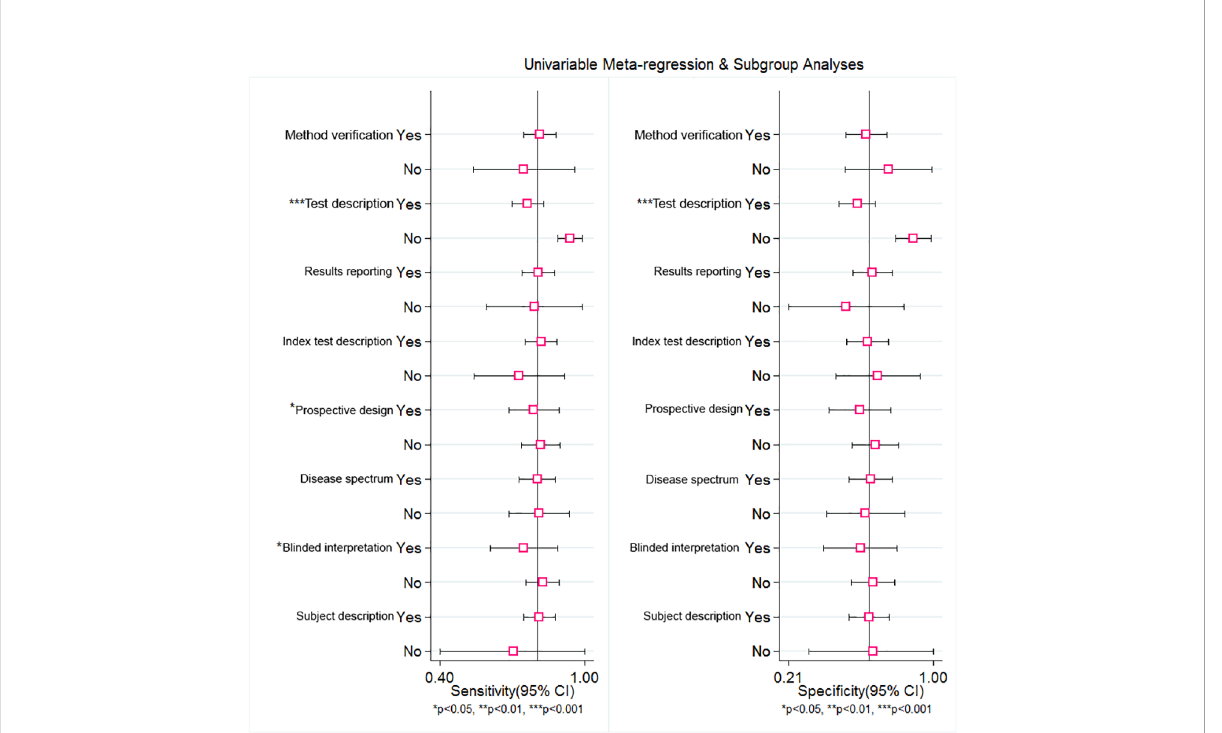
FIGURE 8 Univariable Meta-regression and subgroup analysis of RDW for predicting of mortality in adult sepsis patients. The forest plot indicated that Test description, Prospective design and Blinded may be responded for the